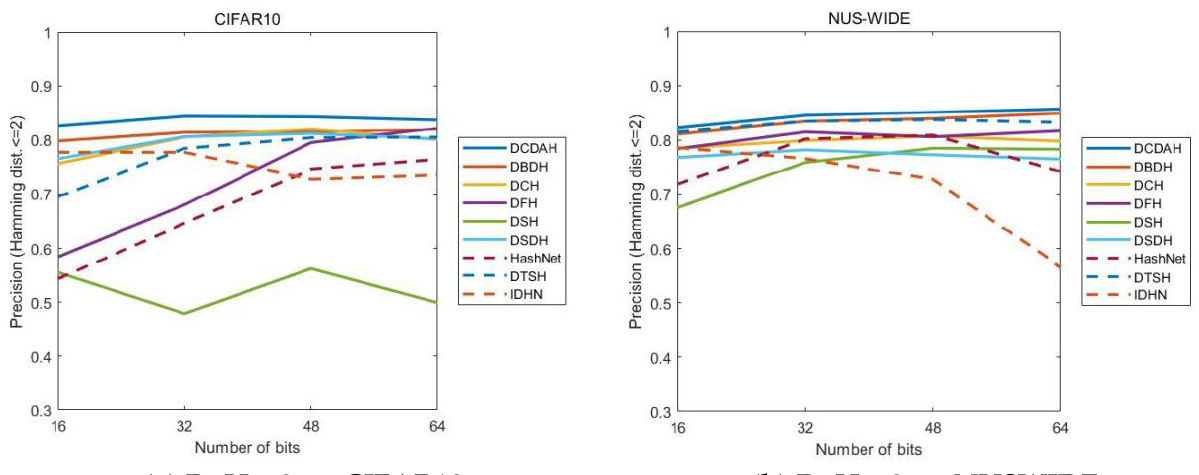
Figure 7. P@H = 2 on two data sets.